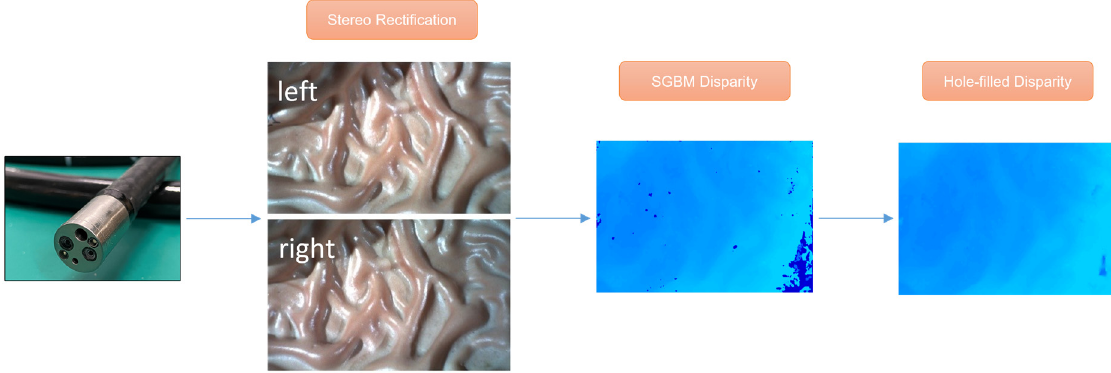
Figure 2. Procedure of proceeding